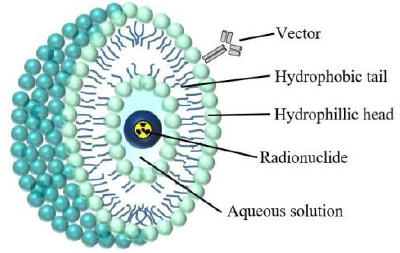
Figure 2. Structure of the liposome.